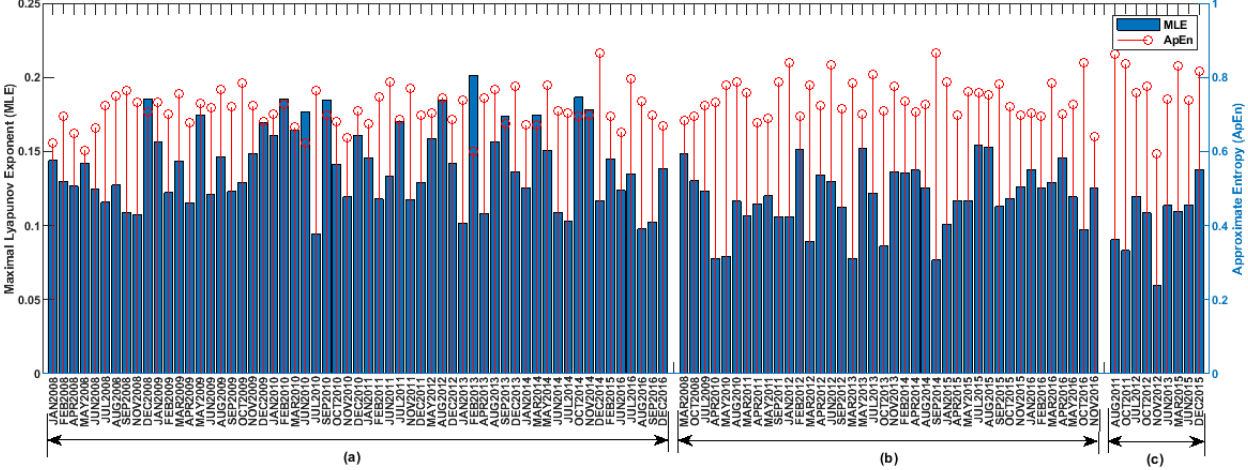
Figure 6. The MLE (bar plot) and ApEn (stem plot) of solar wind electric field (VB s ) during: (a) minor, (b) moderate and (c) major geomagnetic